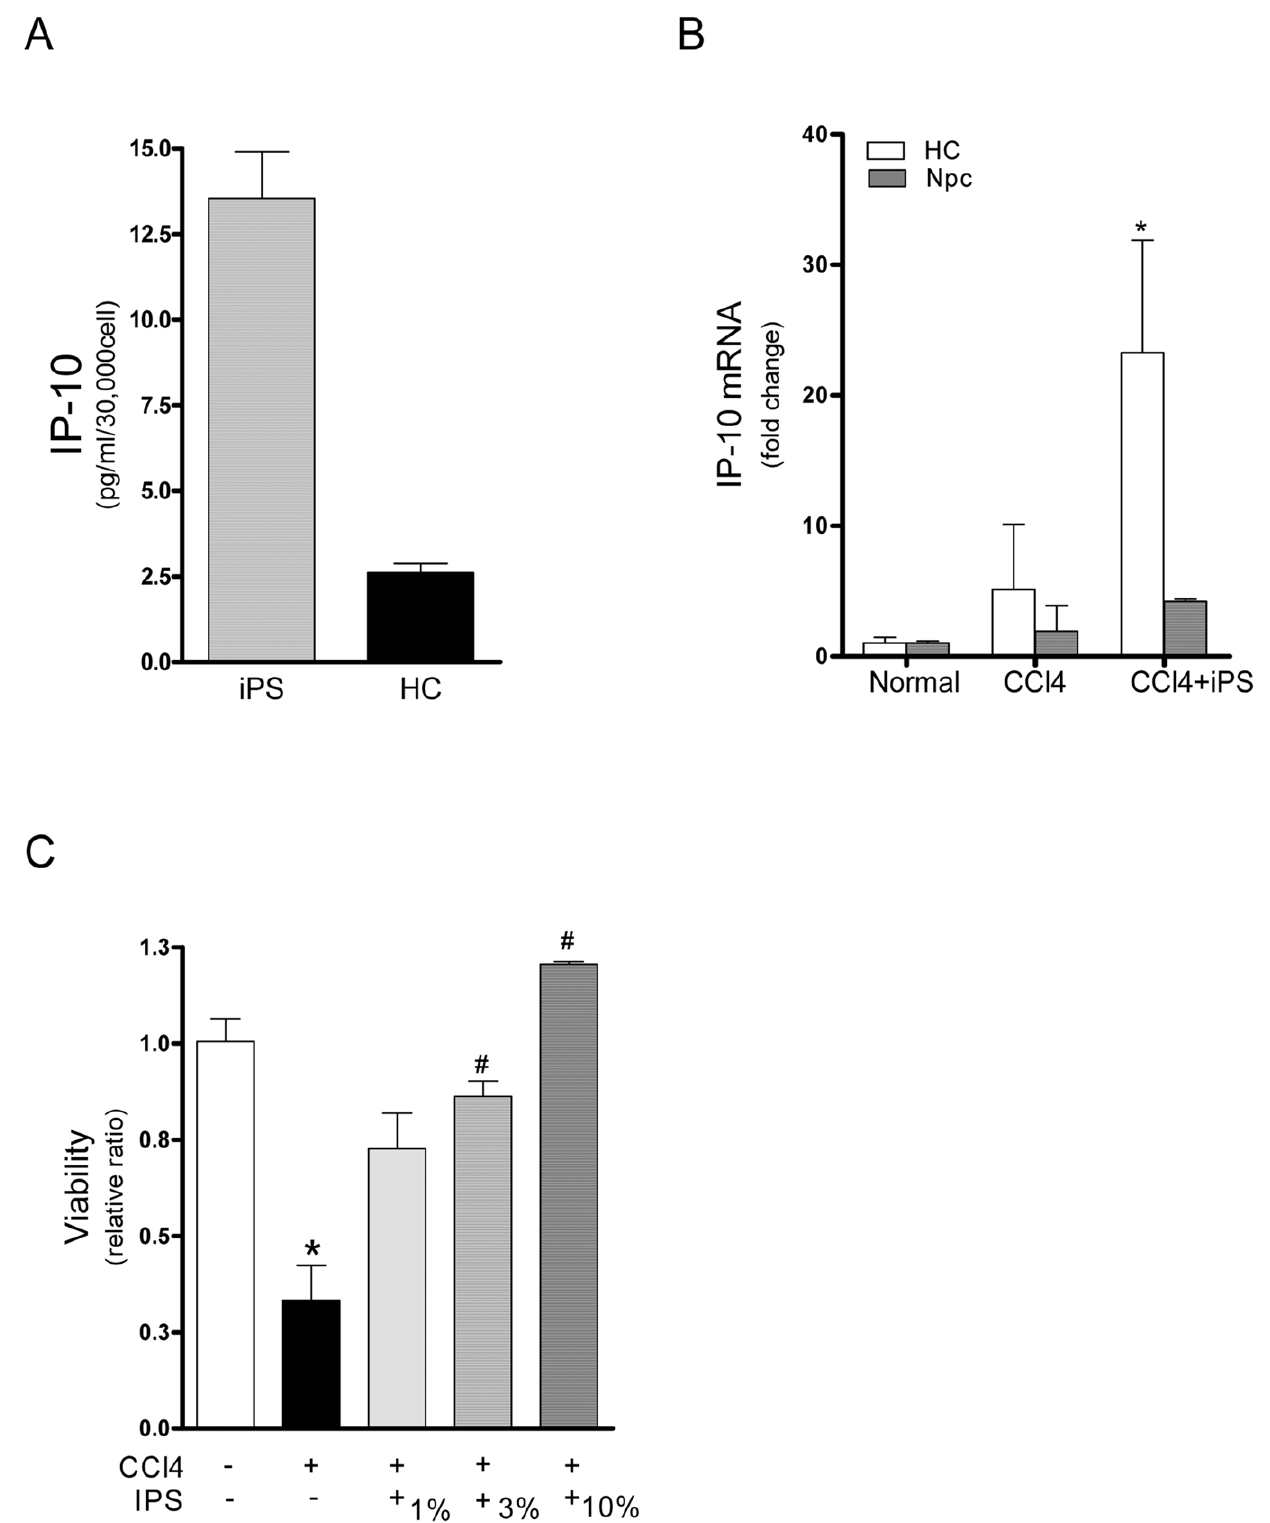
Figure 4. The cellular source and the beneficial effects of IP-10. ( A ) In vitro cultured iPS secreted IP-10 into culture medium. ( B ) Mice primary hepatocytes (HC) and none-parenchymal cells (Npc) were isolated from normal and injured mice livers at 24 h post-injury. After iPS infusion, increased expression of IP-10 mRNA were observed mainly in HC from injured liver after iPS treatment (n=3). ( C ) Mice none-transformed hepatocytes (AML12) were co-cultured with iPS. iPS increased the viability of the CCl 4 -injured hepatocytes (n=3 independent experiment).